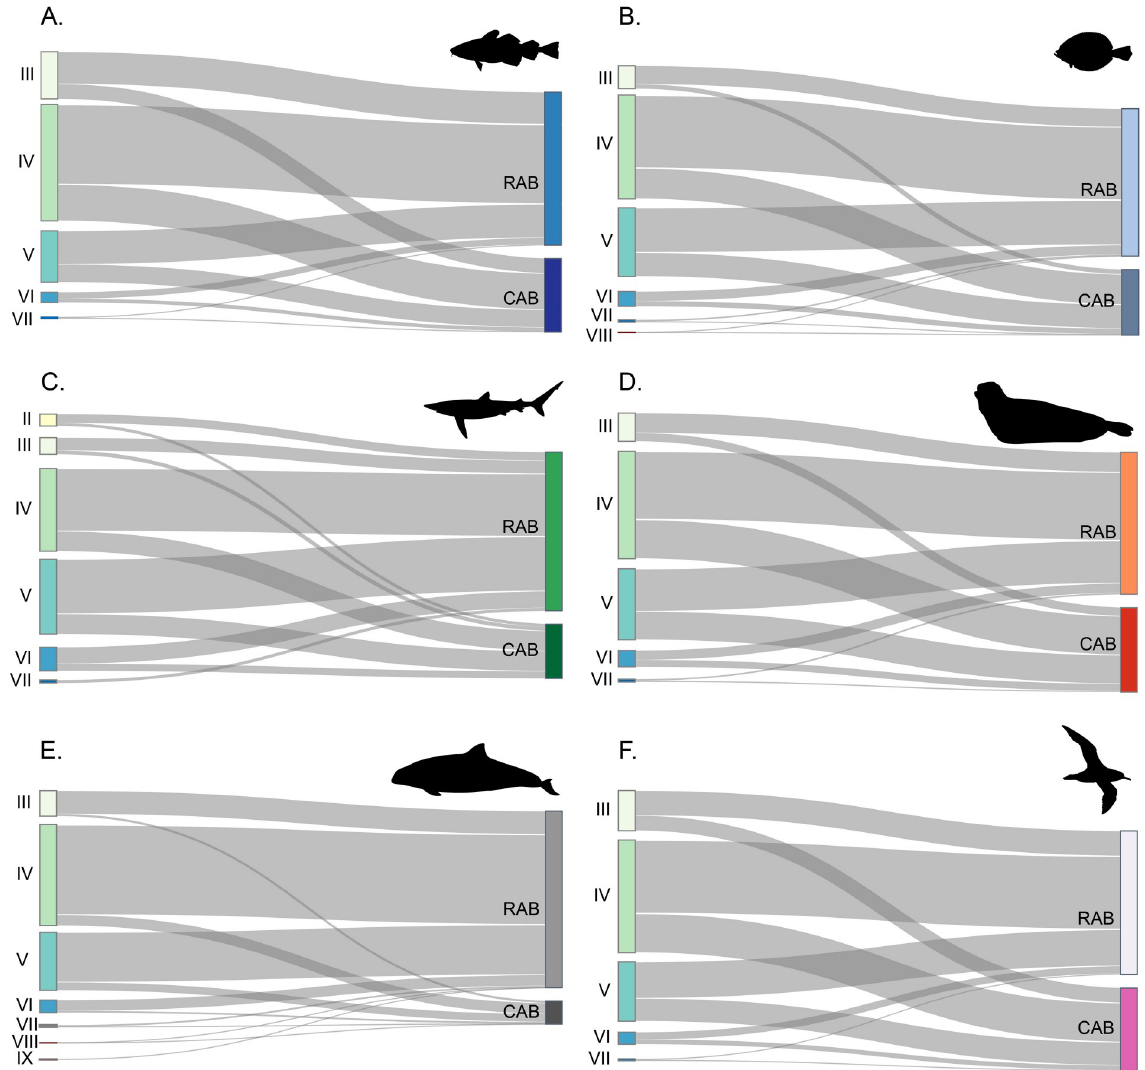
Fig 5. Trophic level decomposition of key species in the Northeast US marine ecosystem. Roman numerals represent the discrete trophic levels of the functional groups in the Contemporary Alosine Biomass (CAB) and Restored Alosine Biomass (RAB) models. (A) Large Atlantic cod, Gadus morhua . (B) Large summer flounder, Paralichthys dentatus . (C) Pelagic sharks, Sphyrna sp., Carcharodon Carcharias , Prionace glauca , Isurus sp., Lamna nasus , and Alopias vulpinus . (D) Pinnipeds, Phoca vitulina , Halichoerus grypus , Pagophilus groenlandicus , and Cystophora cristata . (E) Odontocetes, Delphinus delphis , Globicephala sp., Grampus griseus , Kogia sp., Lagenorhynchus acutus , Phocena phocena , Physeter macrocephalus , Stenella coeruleoalba , S . frontalis , Tursiops truncatus , Ziphius sp. (F) Seabirds, Calonectris diomedae , Fulmarus glacialis , Larus marinus , L . argentatus , L . philadelphia , Oceanites oceanicus , Phalaropus fulicarius , Puffinus gravis , P . griseus , Rissa tridactyla , Sula bassanus